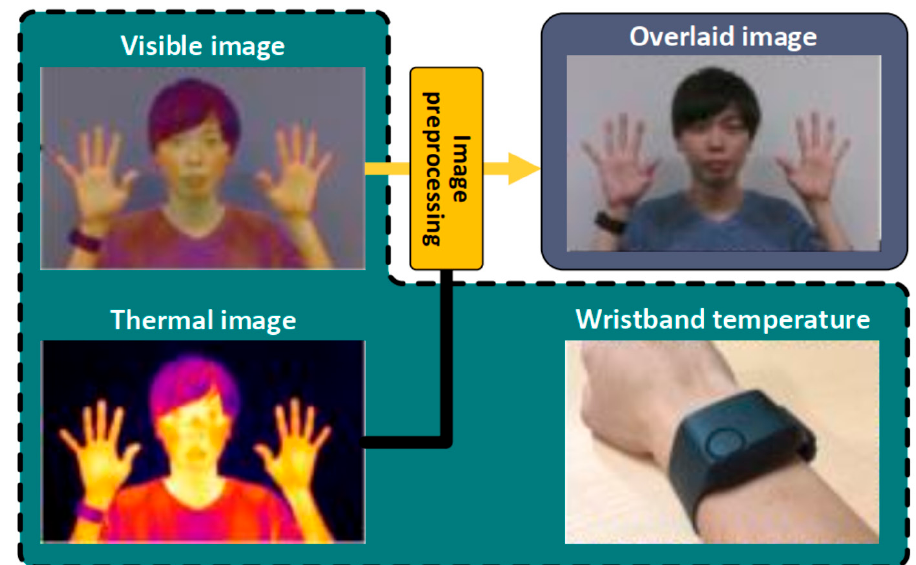
Figure 12. Human body temperature calculation using thermal camera and wristband temperature sensor (Modified from [148]).